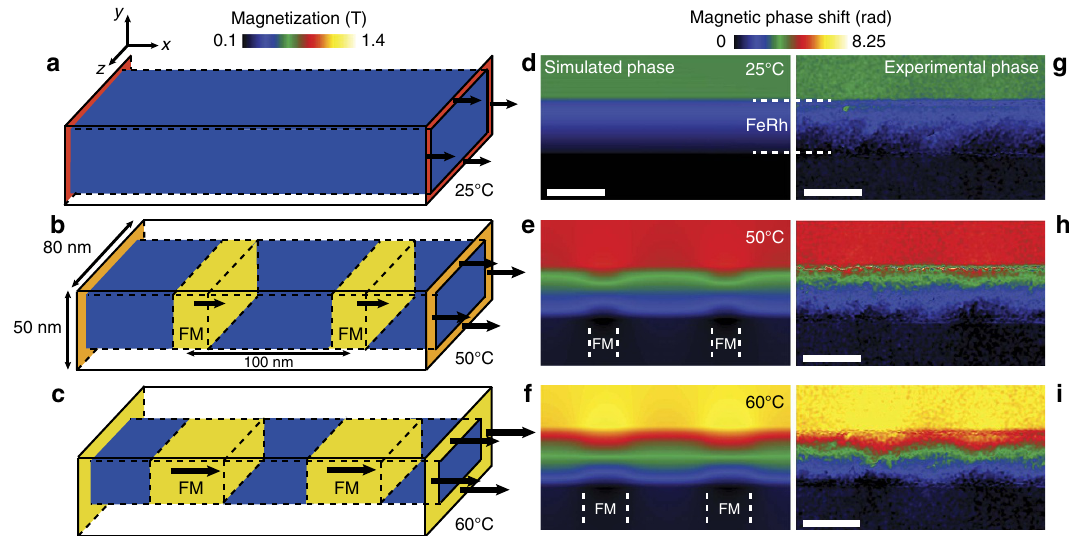
Figure 6 | Micromagnetic simulations and comparison with experimental phase images. ( a – c ) 3D schemes used for the micromagnetic simulations of the area enclosed by the white rectangle in Fig. 5b,d,f (25, 50 and 60 (cid:2) C respectively). The ferromagnetic damaged surfaces are not represented for clarity. ( d – i ) Comparison between simulated magnetic phase images calculated from micromagnetic simulations and ( h – j ) experimental magnetic phase images obtained at same temperatures. Scale bars represent